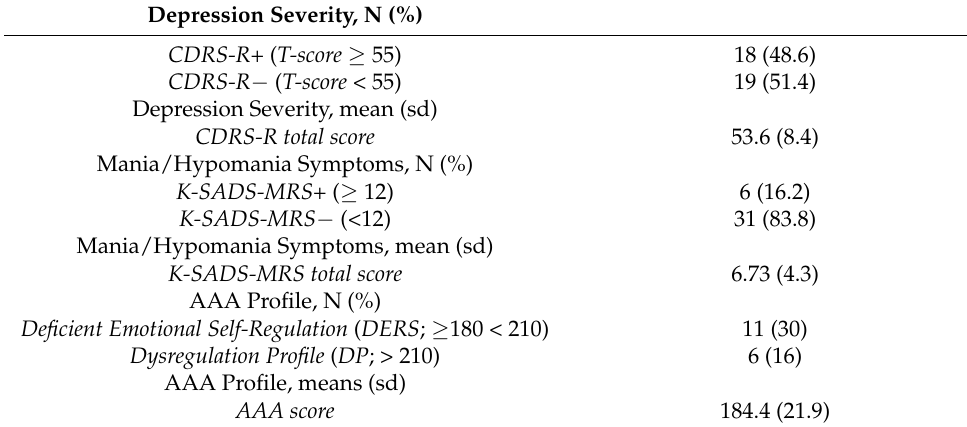
Table 2. Descriptive statistics for the questionnaire and interviews